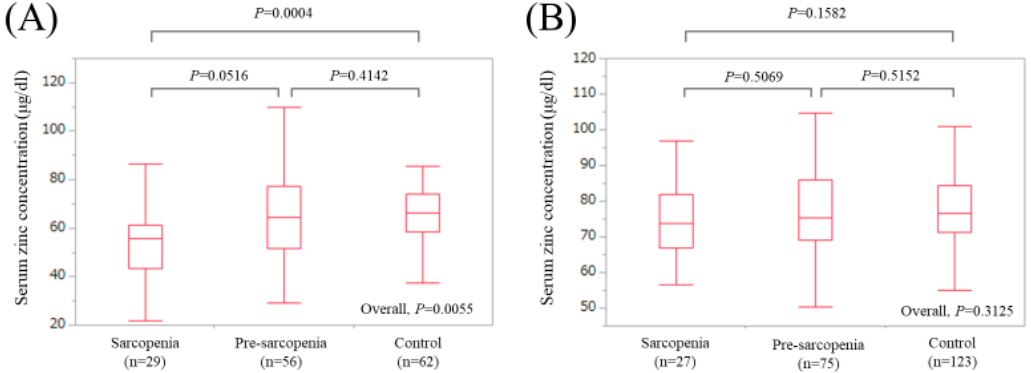
Figure 4. Boxplots of serum Zn concentration in the High-Zn, Intermediate-Zn, and Low-Zn groups in patients with LC ( A ) and non-LC ( B ). In LC patients, the median (IQR) serum Zn concentrations in sarcopenia, pre-sarcopenia, and control were 55.7 (43.15, 61.4) µ g/dL, 64.6 (51.55, 77.325) µ g/dL, and 66.4 (58.45, 74.175) µ g/dL, respectively. In non-LC patients, the median (IQR) serum Zn concentrations in sarcopenia, pre-sarcopenia, and control were 73.9 (66.9, 81.9) µ g/dL, 75.4 (69.0, 86.0) µ g/dL, and 76.5 (71.2, 84.3) µ g/dL, respectively.